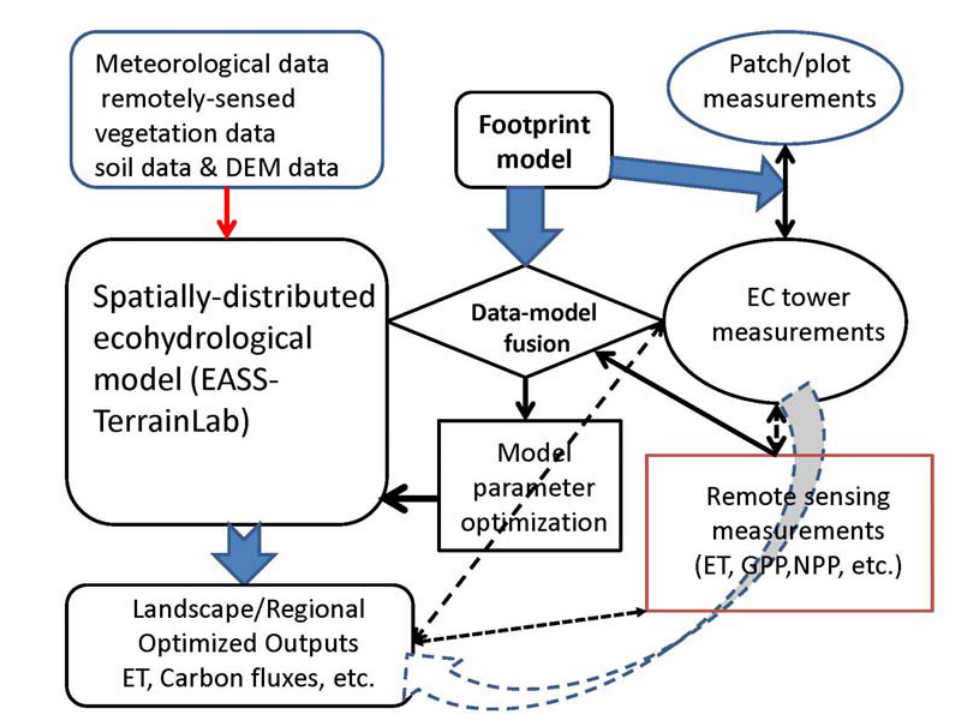
Figure 5. An upscaling framework synthetically integrating ecohydrologcal and footprint modeling, remote sensing and land surface